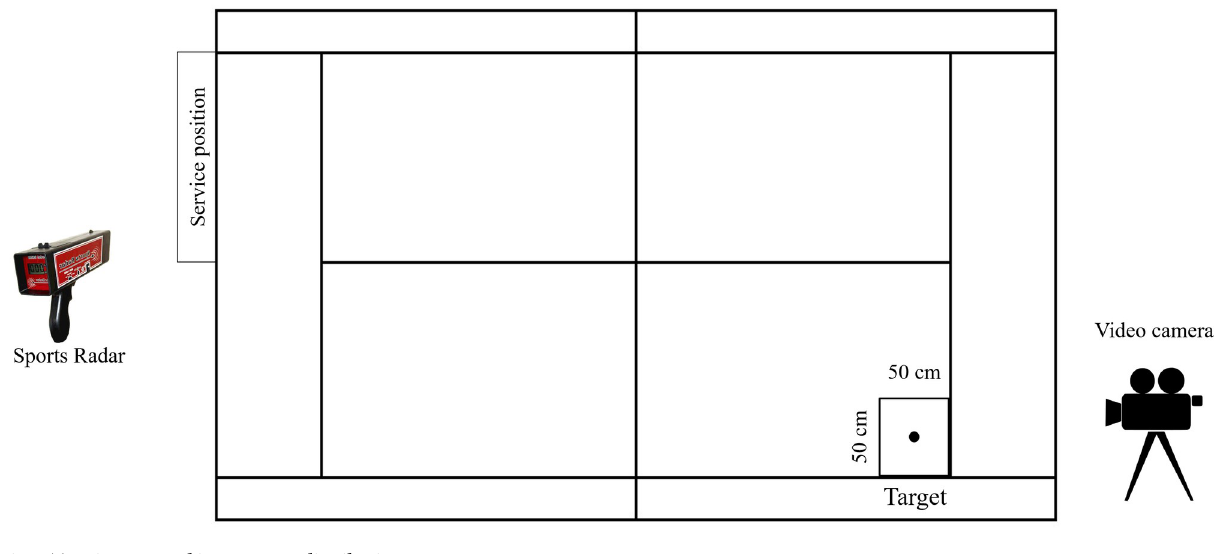
Fig 1. Tennis court and instruments